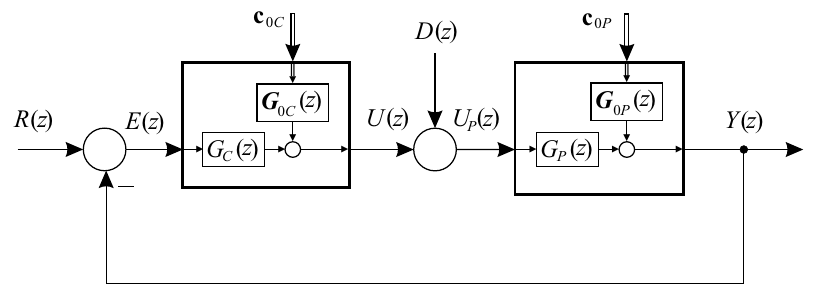
Figure 3. Full block diagram of the closed loop system.